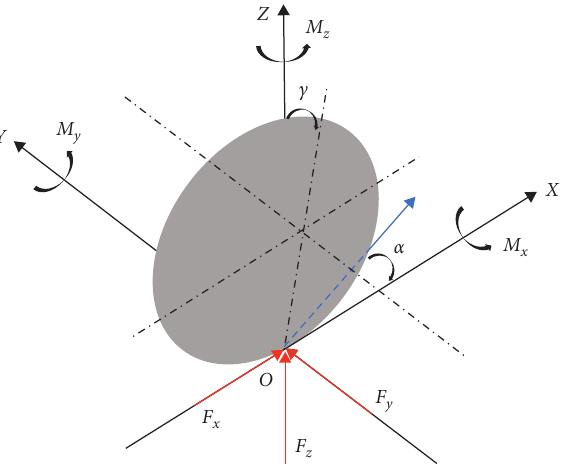
Figure 5: Schematic of six-dimensional wheel force. F dinal force, F y : lateral force, F z : vertical force, M x : heeling moment, M y : twist torque, M z : aligning torque, α : sideslip angle, and c : camber